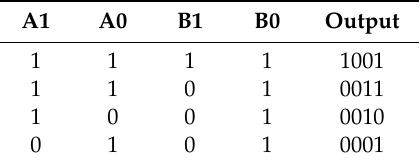
Figure 5. Multiplication steps of 4 × 4 Vedic multiplier. Table 2. Operation of the 2 × 2 Vedic multiplier.